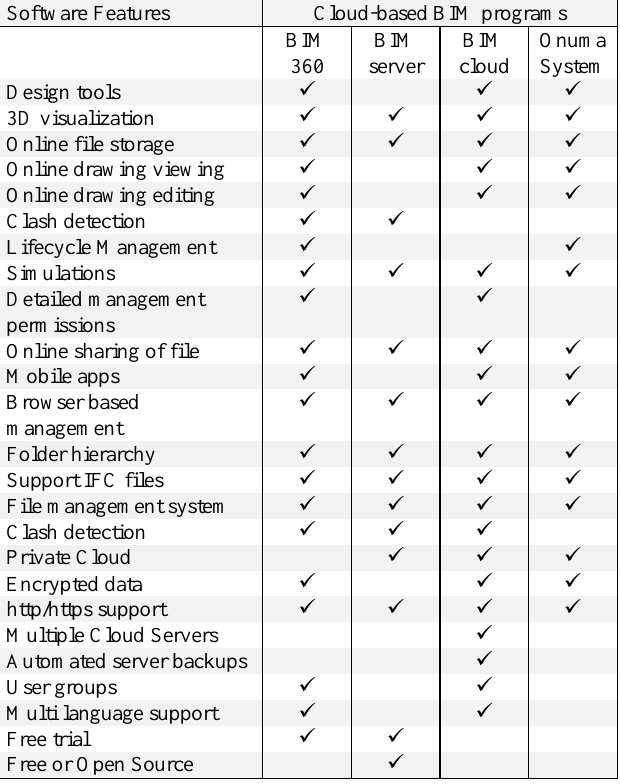
Table 1. Comparison of features of Cloud-based BIM programs ((Chong et al., 2014) & Web 2, 3, 4,